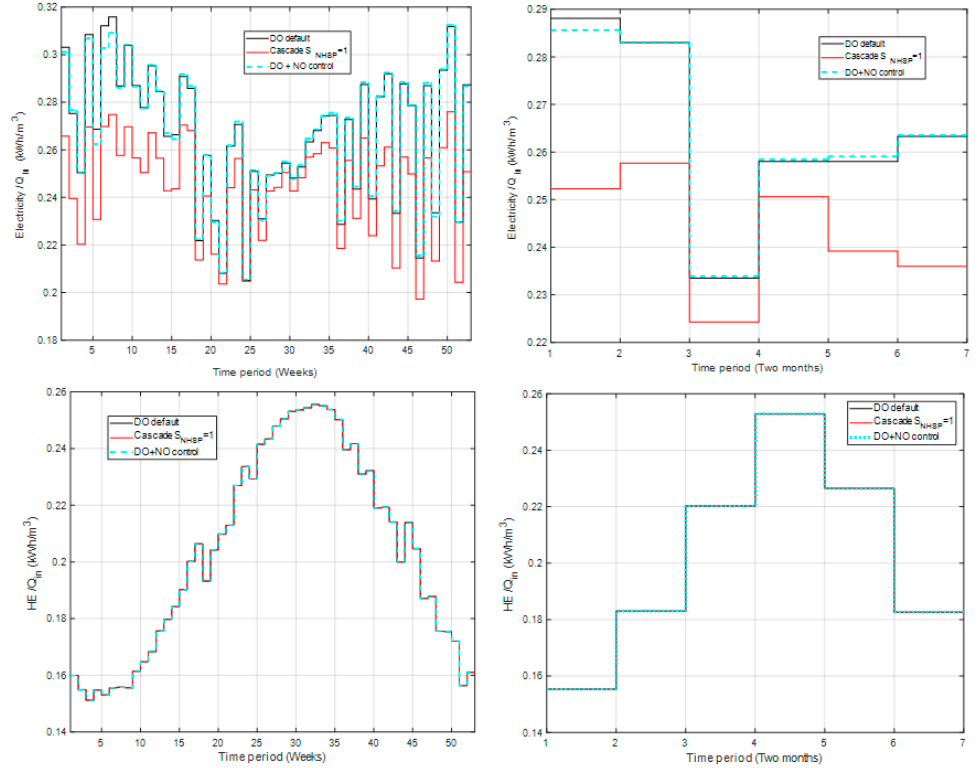
Figure 4. Weekly and bimonthly profiles of environmental indicators associated with energy use: electricity consumption, Electricity/Q in (kW h/m 3 ); heating energy, HE/Q in (kW h/m 3 ). Electricity consumption is associated with control movements of the control schemes (i.e., aeration energy, pumping energy), then the frequent variations observed in the weekly profile of the control schemes that keep a constant DO set-point (DO default and DO + NO control) are associated with control actions that keep DO close to set-point in the presence of disturbances in the load. The similitude between DO default and DO + NO control profiles suggest that variations in electricity consumption are mainly produced by aeration. On the other hand, the Cascade S NHSP scheme exhibits variations with load similar to the variations observed with DO-based control schemes, but electricity consumption is significantly reduced since it is not necessary to increase aeration to keep a fixed DO- set point. In the bimonthly profiles, the periods of maximum and minimum consumption coincide with DO-based schemes, but the variation pattern is completely different.